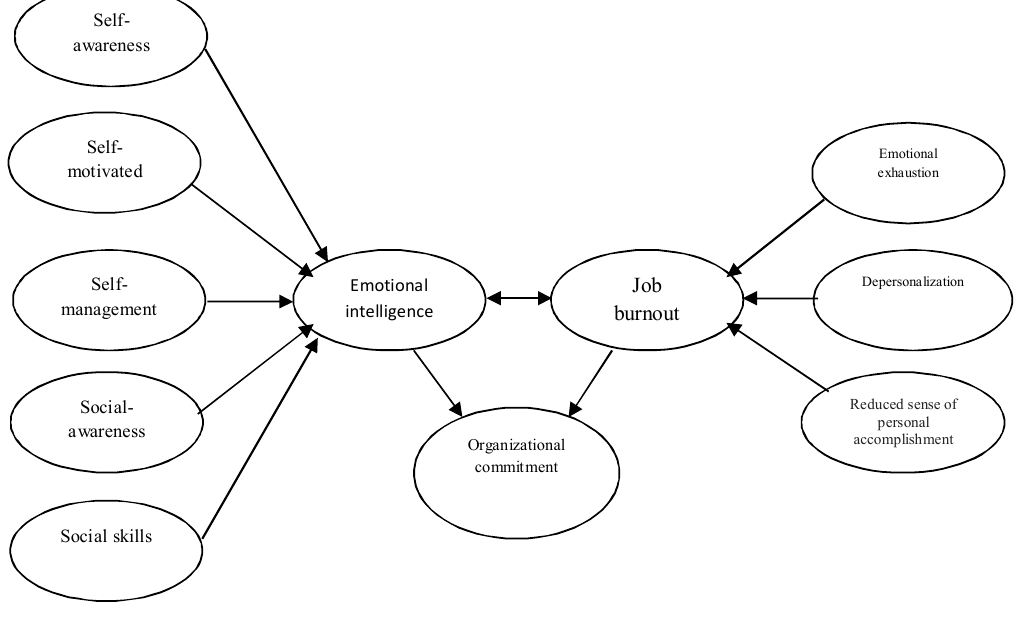
Fig. 1. The proposed study: The relationship between emotional intelligence, job burnout and organizational